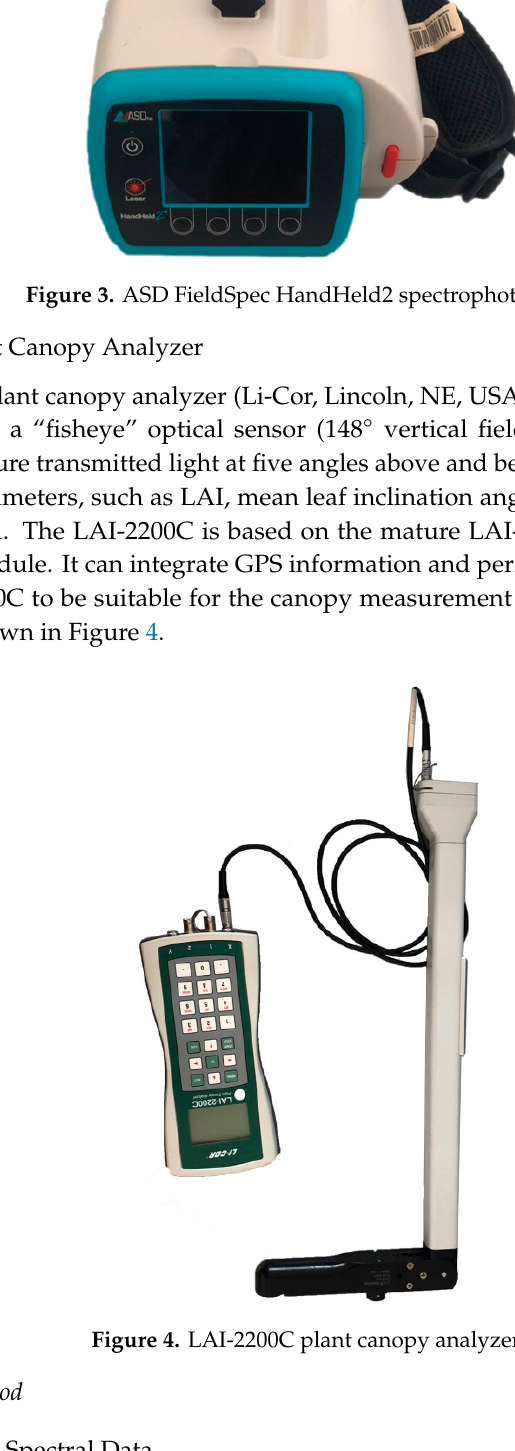
Figure 4. LAI-2200C plant canopy analyzer.